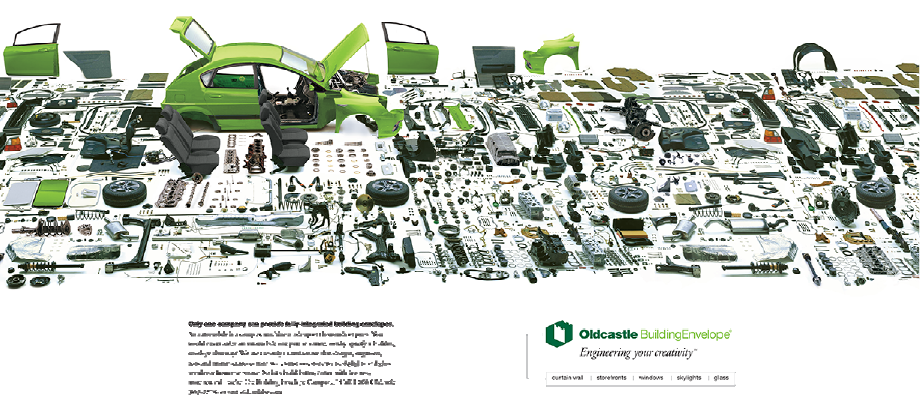
Figure 15. Oldcastle BuildingEnvelope ® (Courtesy Brian J. Ganton &